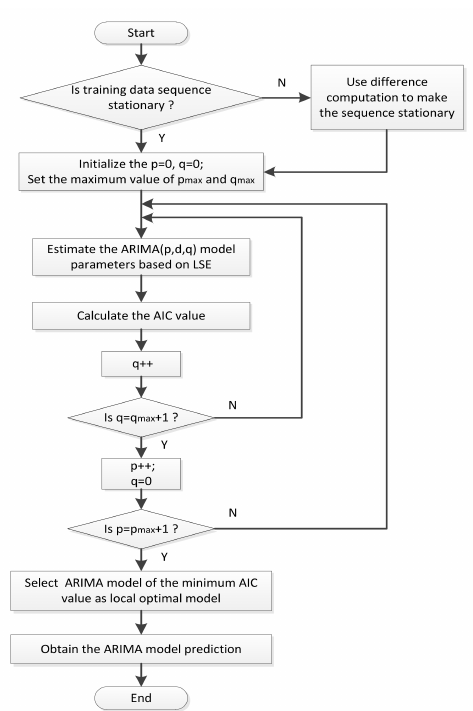
Figure 1. Framework of autoregressive integrated moving average (ARIMA) model and